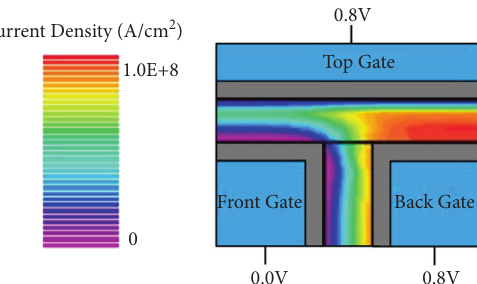
Figure 7: The current density distribution of the PSF-TiFETdevice at V ds � 0.8V at Turn-on State